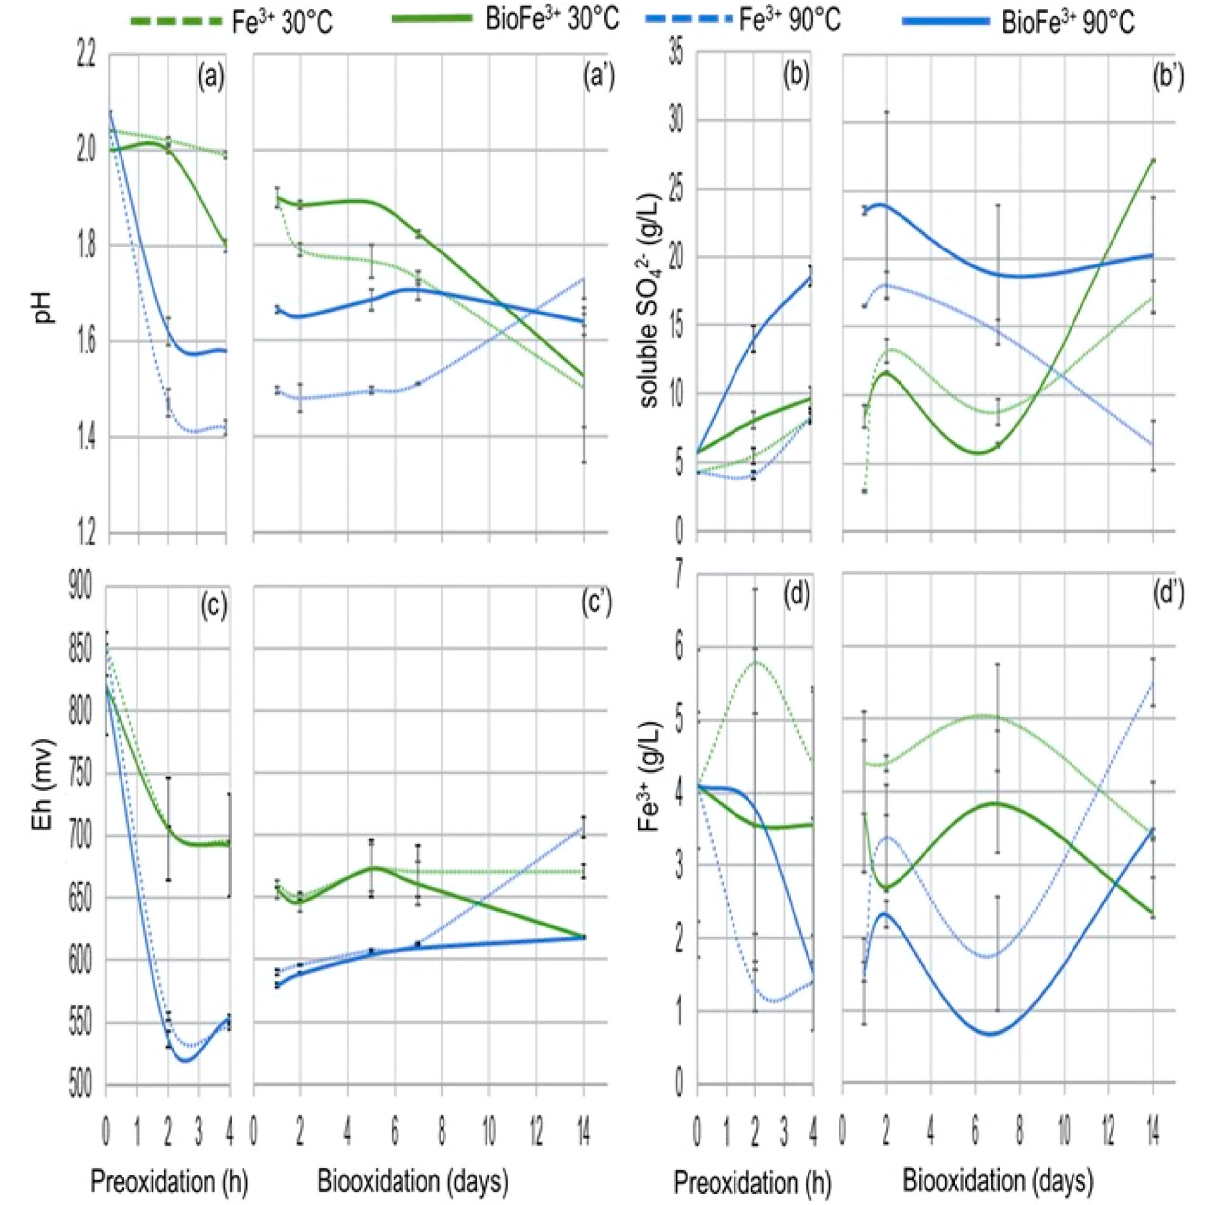
Figure 3. Results of pH, sulfate concentration, redox potential, and ferric ion concentration during: ( a – d ) FeS 2 concentrate (10% w / v ) preoxidation with bioferric (BioFe 3+ ) (solid lines) or with ferric sulfate, Fe 3+ (dotted lines) at 30 ◦ C (green lines) or 90 ◦ C (blue lines) and during ( a’ – d’ ) bio-oxidation of the preoxidized FeS 2 concentrate at 30 and 90 ◦ C with BioFe 3+